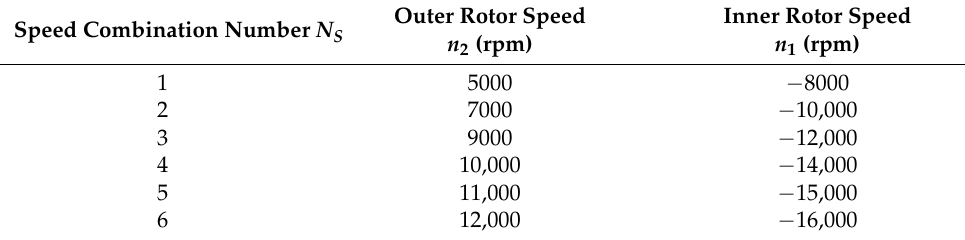
Table 3. Inner and outer rotor speeds for the six speed